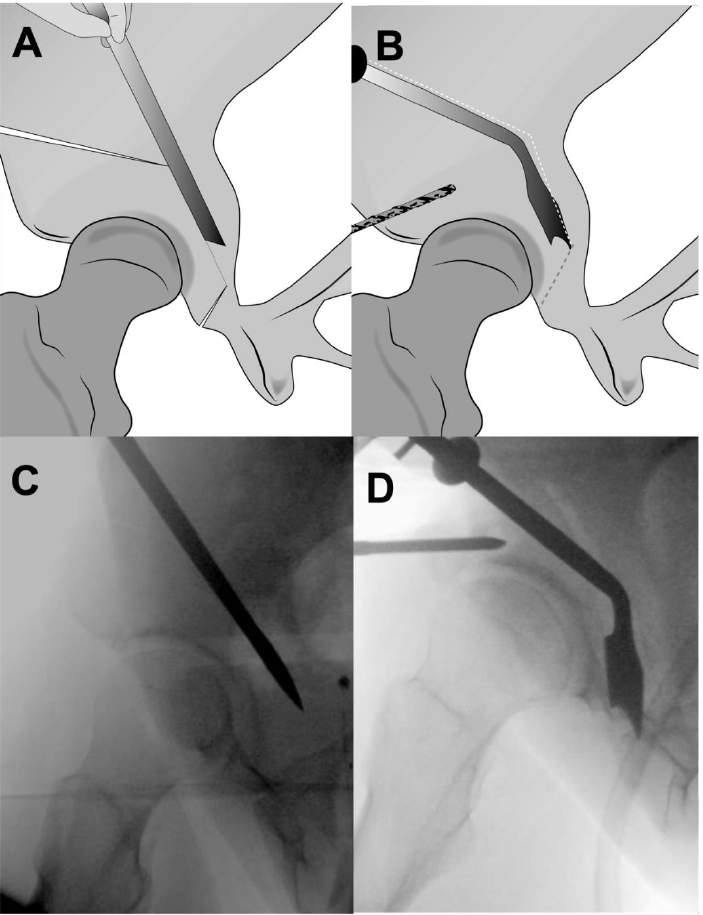
Figure 9. ( A ) Illustration showing the retrotrochanteric cut through the posterior column directed towards the ischium. ( B ) An angled osteotome helps to free the fragment by separating the final bony bridges. ( C ) Fluoroscopic image depicting the iliac oblique view of retrotroachteric osteotomy. ( D ) Fluoroscopic image depicting the process of freeing up the acetabular fragment by separating the residual bridges between ischial osteotomy and retrotrochanteric